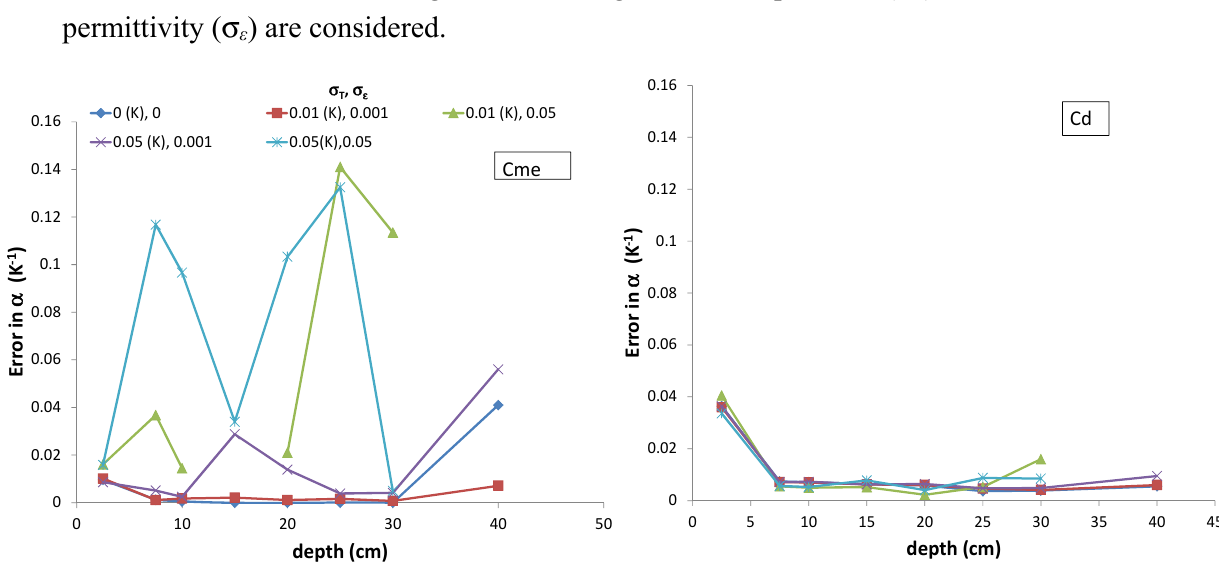
) and the dielectric T